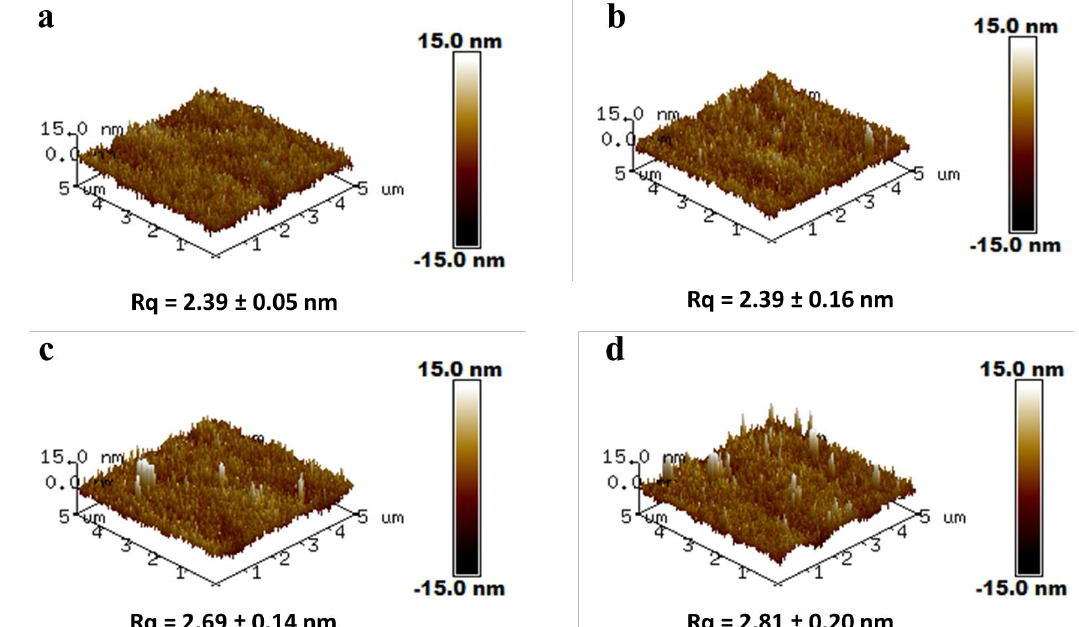
Figure 2. Three-dimensional AFM images of the membranes coated at different reaction times of TA and FeIII: ( a ) PAN; ( b ) 1 min; ( c ) 2 min; ( d ) 3 min; Lateral scale = 5 µ m. Vertical scale = − 15 to 15 nm.